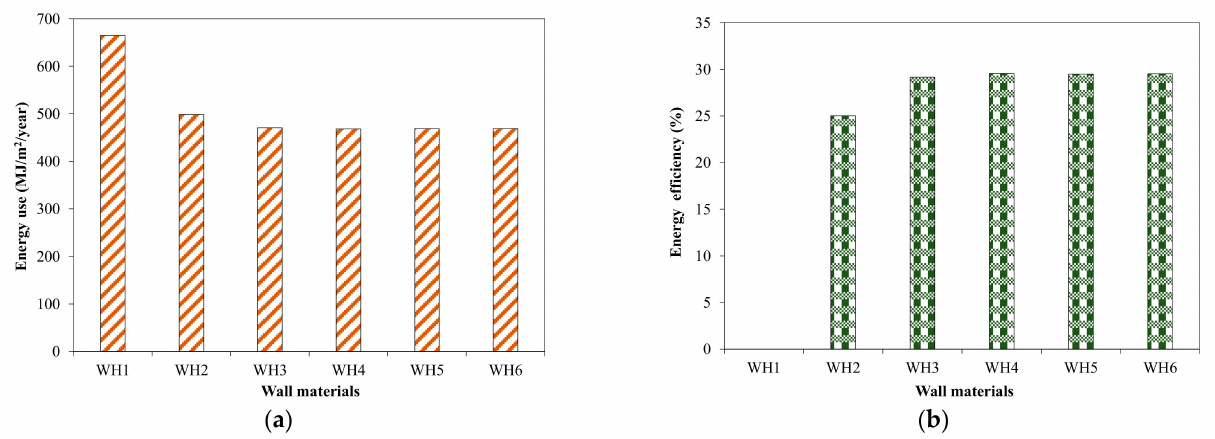
Figure 11. Effect of wall materials on energy use in tested warehouse building. ( a ) Energy use; ( b ) Efficiency.